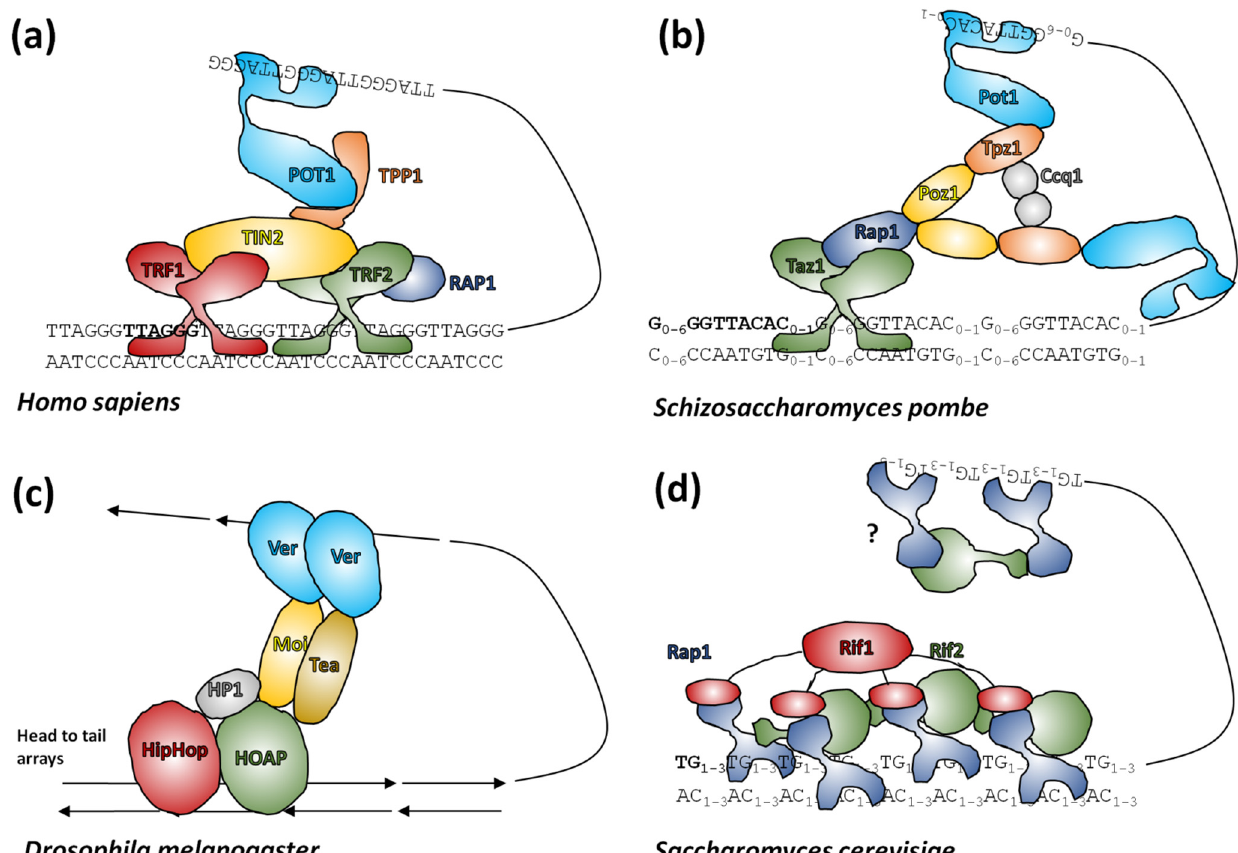
Figure 5. Telomere protection by protein complexes. ( a ) The six core units of shelterin [272] form a complex coating distal telomeres, although stoichiometries of subunits may vary. TRF2 forms T-loops and binds the double-stranded vertebrate telomeric sequence. TRF1 assists this binding, TIN2 and TPP1 form the core of the complex and control other protein-protein interactions and POT1 can bind single-stranded telomeric repeats to stabilize the T-loop. ( b ) Fission yeast shelterin [286] is analogous to vertebrates but differs in stoichiometries of proteins. ( c ) Drosophila terminin [95] has a similar function to shelterin although the precise roles of components that share little homology with shelterin components are speculative. ( d ) Budding yeast telosomes [287]. Rap1 binds telomeric DNA and can be complexed into dimers by Rif2 or tetramers by Rif1. The entire assembly is proposed to form a velcro-like coating of telomeres although to date structural studies of this complex are on dsDNA only, so any interaction with 3 ′ overhangs is speculative.